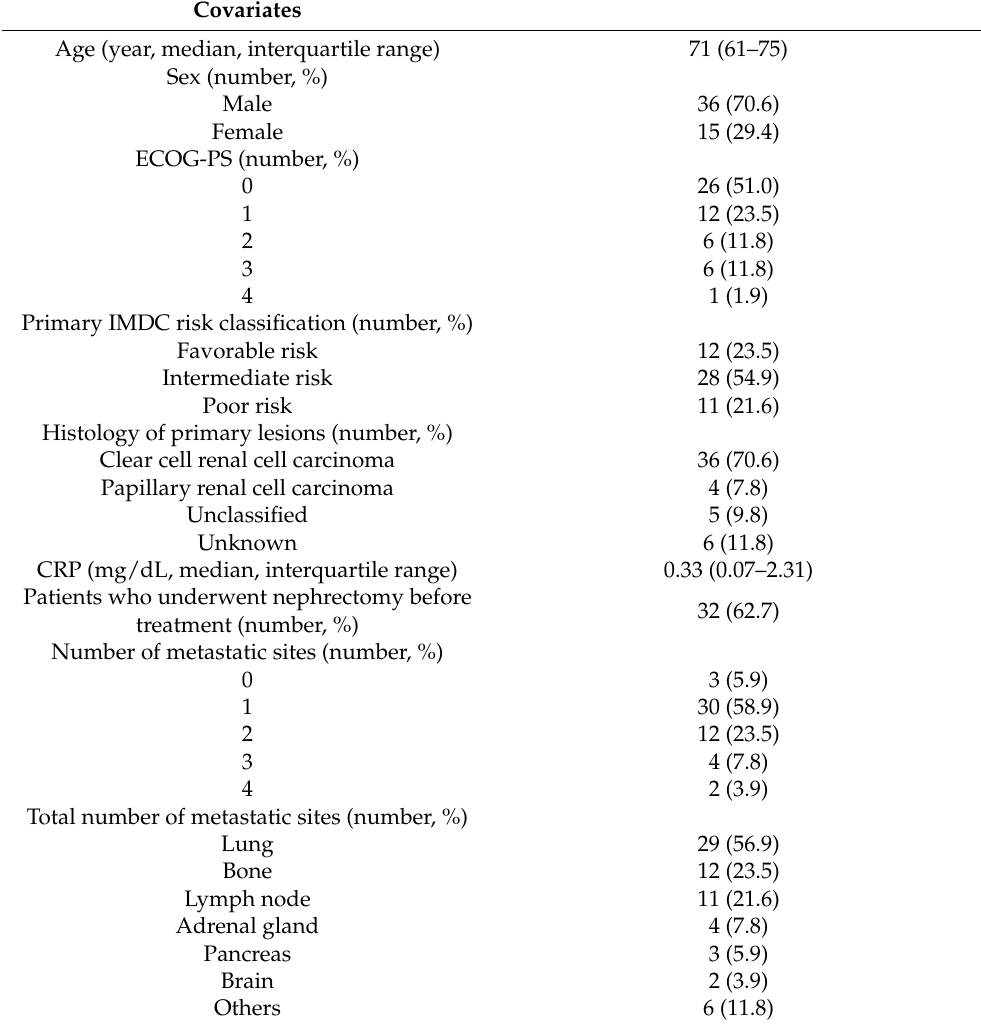
Table 1. Characteristics of the enrolled